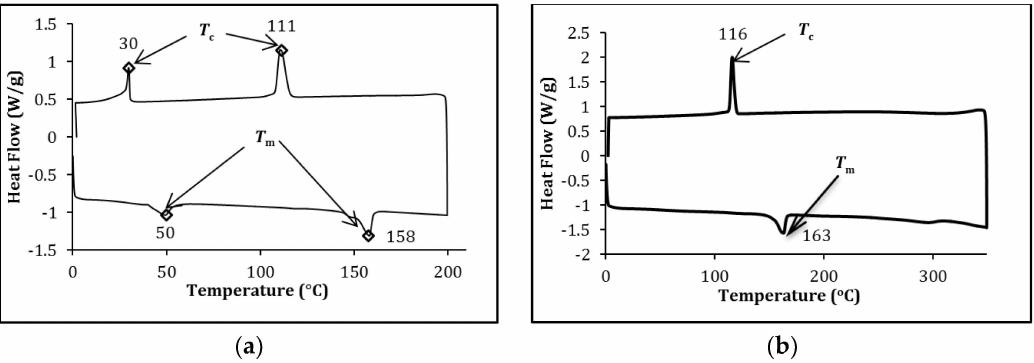
Figure 14. DSC scan of the ( a ) F2 green compact; ( b ) after solvent extraction under 50 mL/min Nitrogen atmosphere with heating rate of 5 ˝